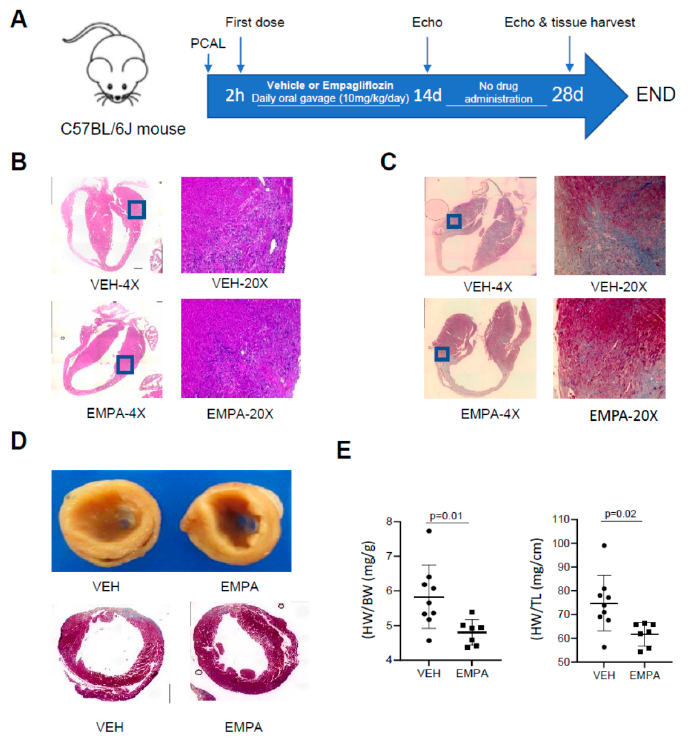
Figure 1. EMPA limits infarct-mediated development of adverse remodeling in WT mice. Age-matched WT mice underwent PCAL and 2 h later were given vehicle (0.5% w/w hydroxyethyl cellulose) or EMPA (10 mg/kg/day) via oral gavage daily. ( A ) Schematic of the protocol; ( B ) representative 4× and 20× magnification of heart sections 3d after PCAL, stained with H&E; 20× enlargement of the border zone to highlight infiltration of immune cells; ( C ) representative 4× and 20× magnification of heart sections with Masson Trichrome staining 14 days after PCAL showing fibrosis; ( D ) representative 20× magnification of heart sections with Masson Trichrome staining 28 days after PCAL showing fibrosis and LV dilation; ( E ) heart weight/body weight (mg/g); heart weight/tibia length (mg/cm), n ≥ 8. Table 1. Assessment of cardiac function and post–infarction cardiac remodeling by echocardiography 14 and 28 days after MI in wild type mice treated with EMPA (10mg/kg/day) or